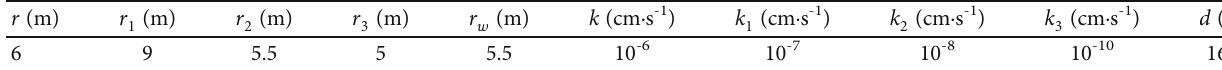
Table 1: Characteristic data for veri fi